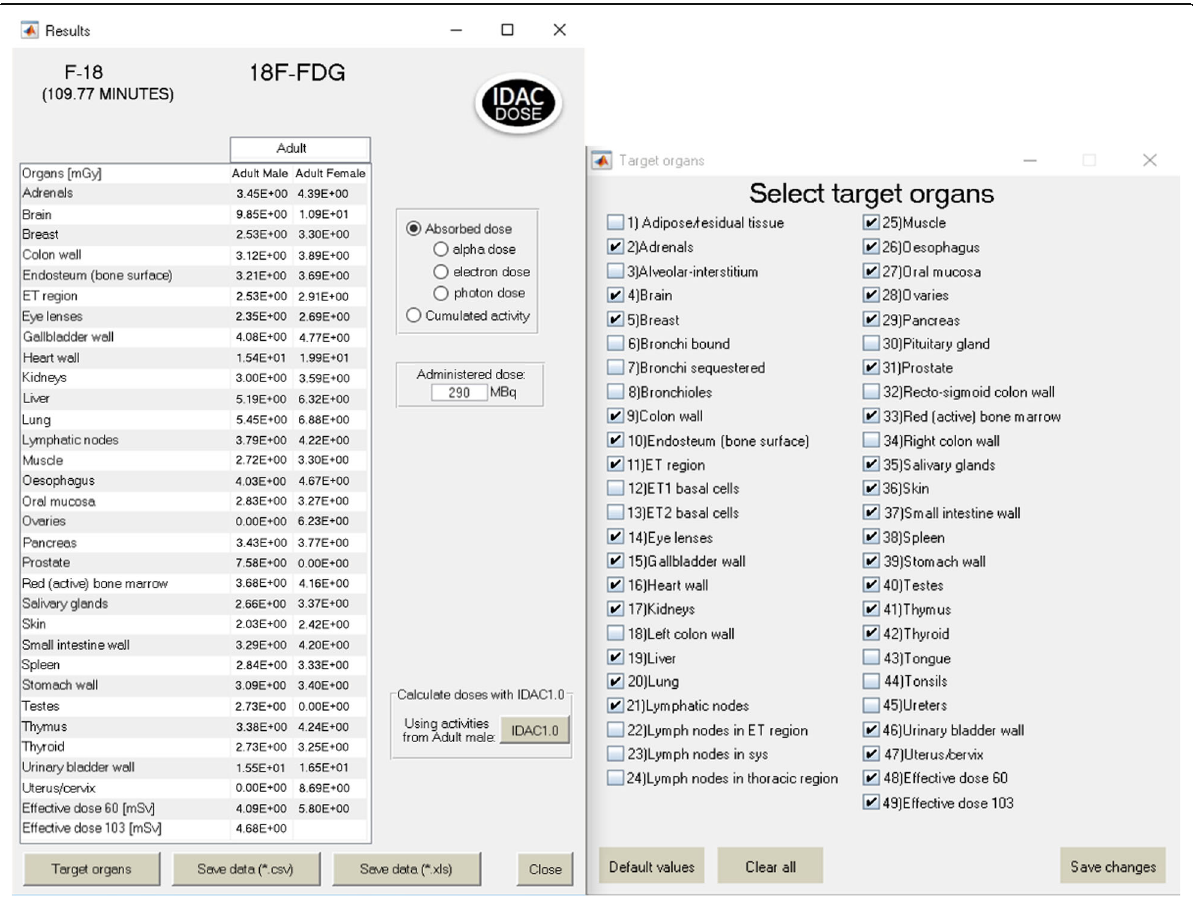
Fig. 2 Using IDAC-Dose2.1 to calculate absorbed dose. Left, absorbed dose (in mGy) for the organs and tissues included in the list of tissues with a weighting factor in ICRP Publication 103 and the effective dose as defined in ICRP Publications 60 and 103 (in mSv) together with the absorbed dose to the lens of the eye for the biokinetic model of the intravenous administration of 290 MBq of 18 F-FDG based on the biokinetic model presented in ICRP Publication 128 [9]. Right, the 47 possible target regions for which absorbed doses are